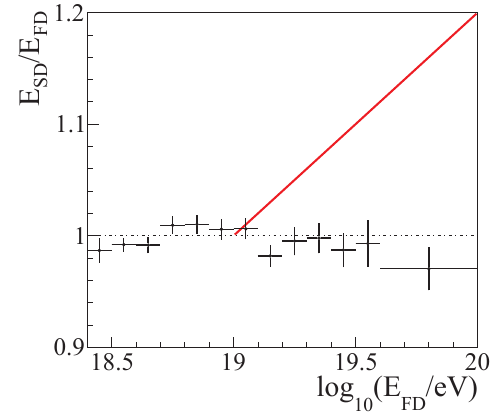
Figure 4. Average ratio of the SD to FD energies in bins of energies for the Auger hybrid events [7]. The red line shows the 20% / decade energy shift above 10 19 eV needed to explain the di ff erence between the Auger and TA